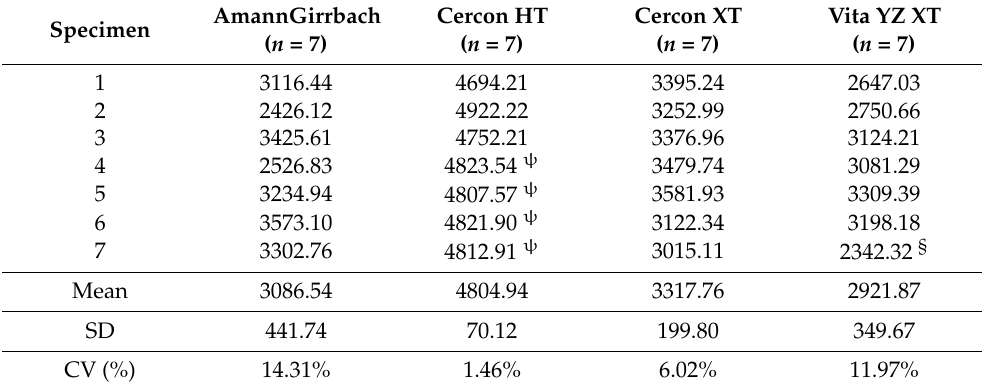
CV = Coefficient of variation, SD = Standard deviation. ψ Tests stopped at these values and the crowns had cracks but did not beak all the way. § Crown had a gap at the margin due to cementing error.